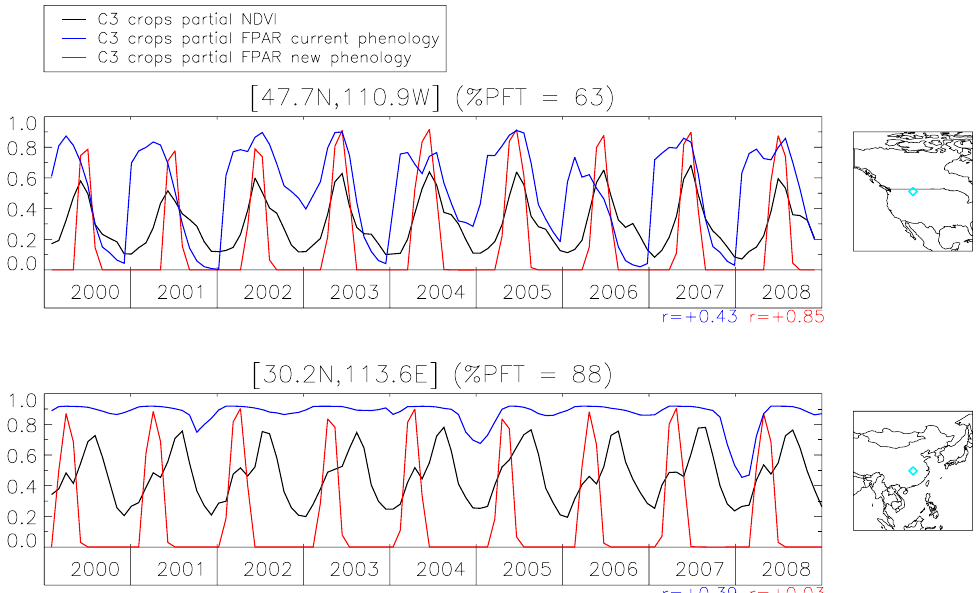
Fig. 7. Time series for two C3 Crops boxes located respectively in the Great Plains of North America (upper plot) and south-east of China (lower plot); NDVI is in black, the FPAR for the current phenology is in blue and the FPAR for the new phenology is in red. The plots give only the signals related to the C3 Crops fraction of the boxes. For the upper plot, the new phenology delivers a C3 Crops FPAR whose phasing with the C3 Crops NDVI has largely been improved ( r = 0.85), as compared to the C3 Crops FPAR of the current phenology ( r = 0.43). For the lower plot box, the C3 Crops NDVI exhibits a regular double cropping signal, the C3 Crops FPAR delivered by the new phenology is in phase with the first observed crop cycle but, as only one crop type is simulated, there is no modeled signal corresponding to the second observed crop cycle, thus resulting in an absence of correlation ( r = 0.03).